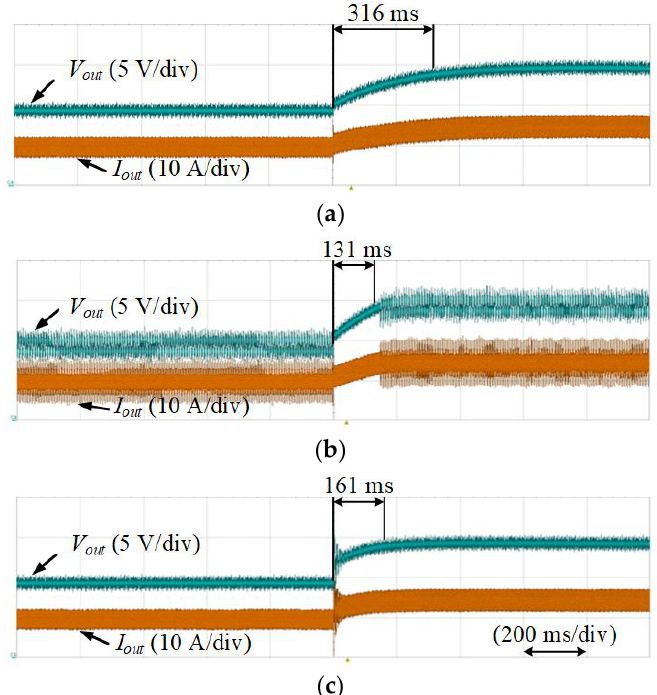
Figure 16. Experimental results of the PSFB-CT converter using three different controllers. ( a ) the PI controller; ( b ) SMC; and ( c ) proposed hybrid fuzzy SMC.